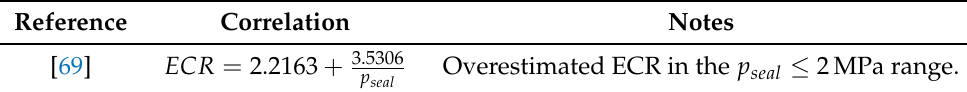
Table 8. Correlations for electrical contact resistance ECR in [m Ω · cm 2 ] between GDL and